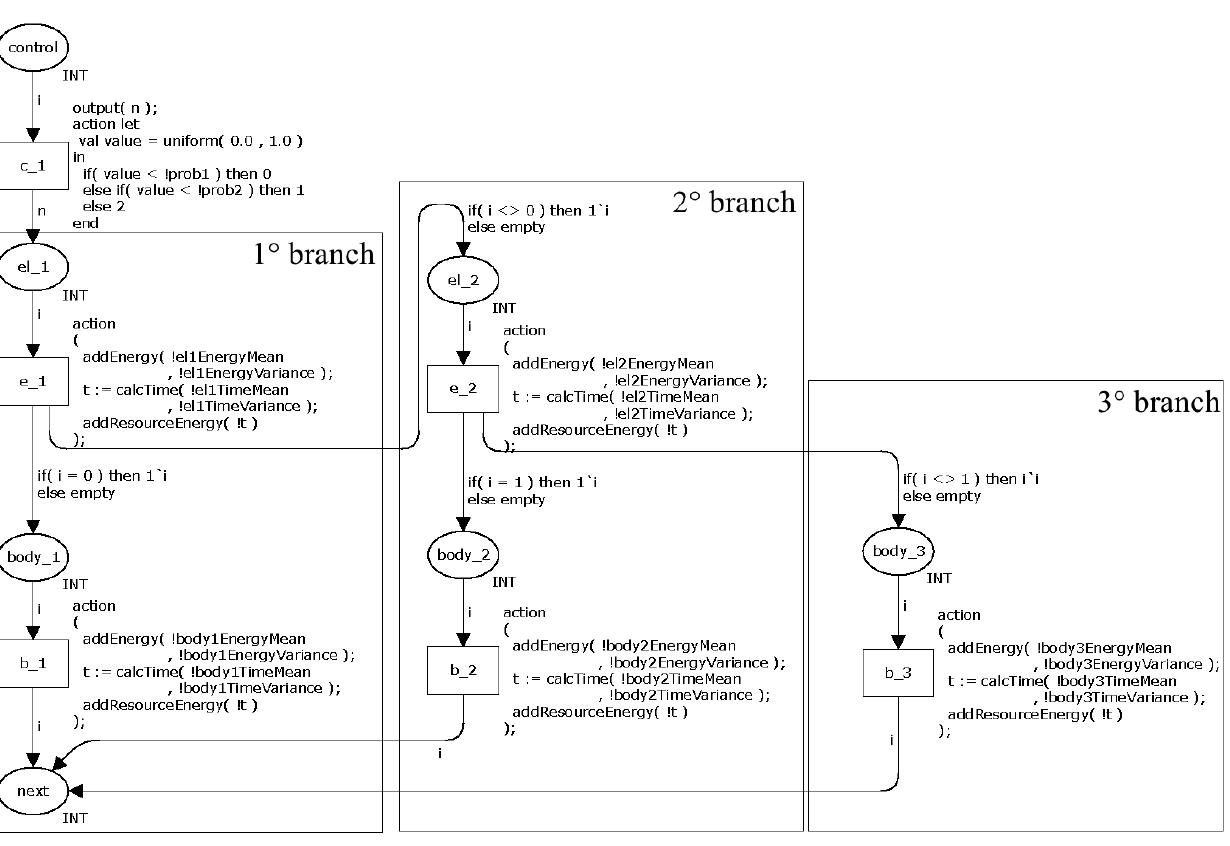
Figure 4. CPN model of the commands if-then-else and switch